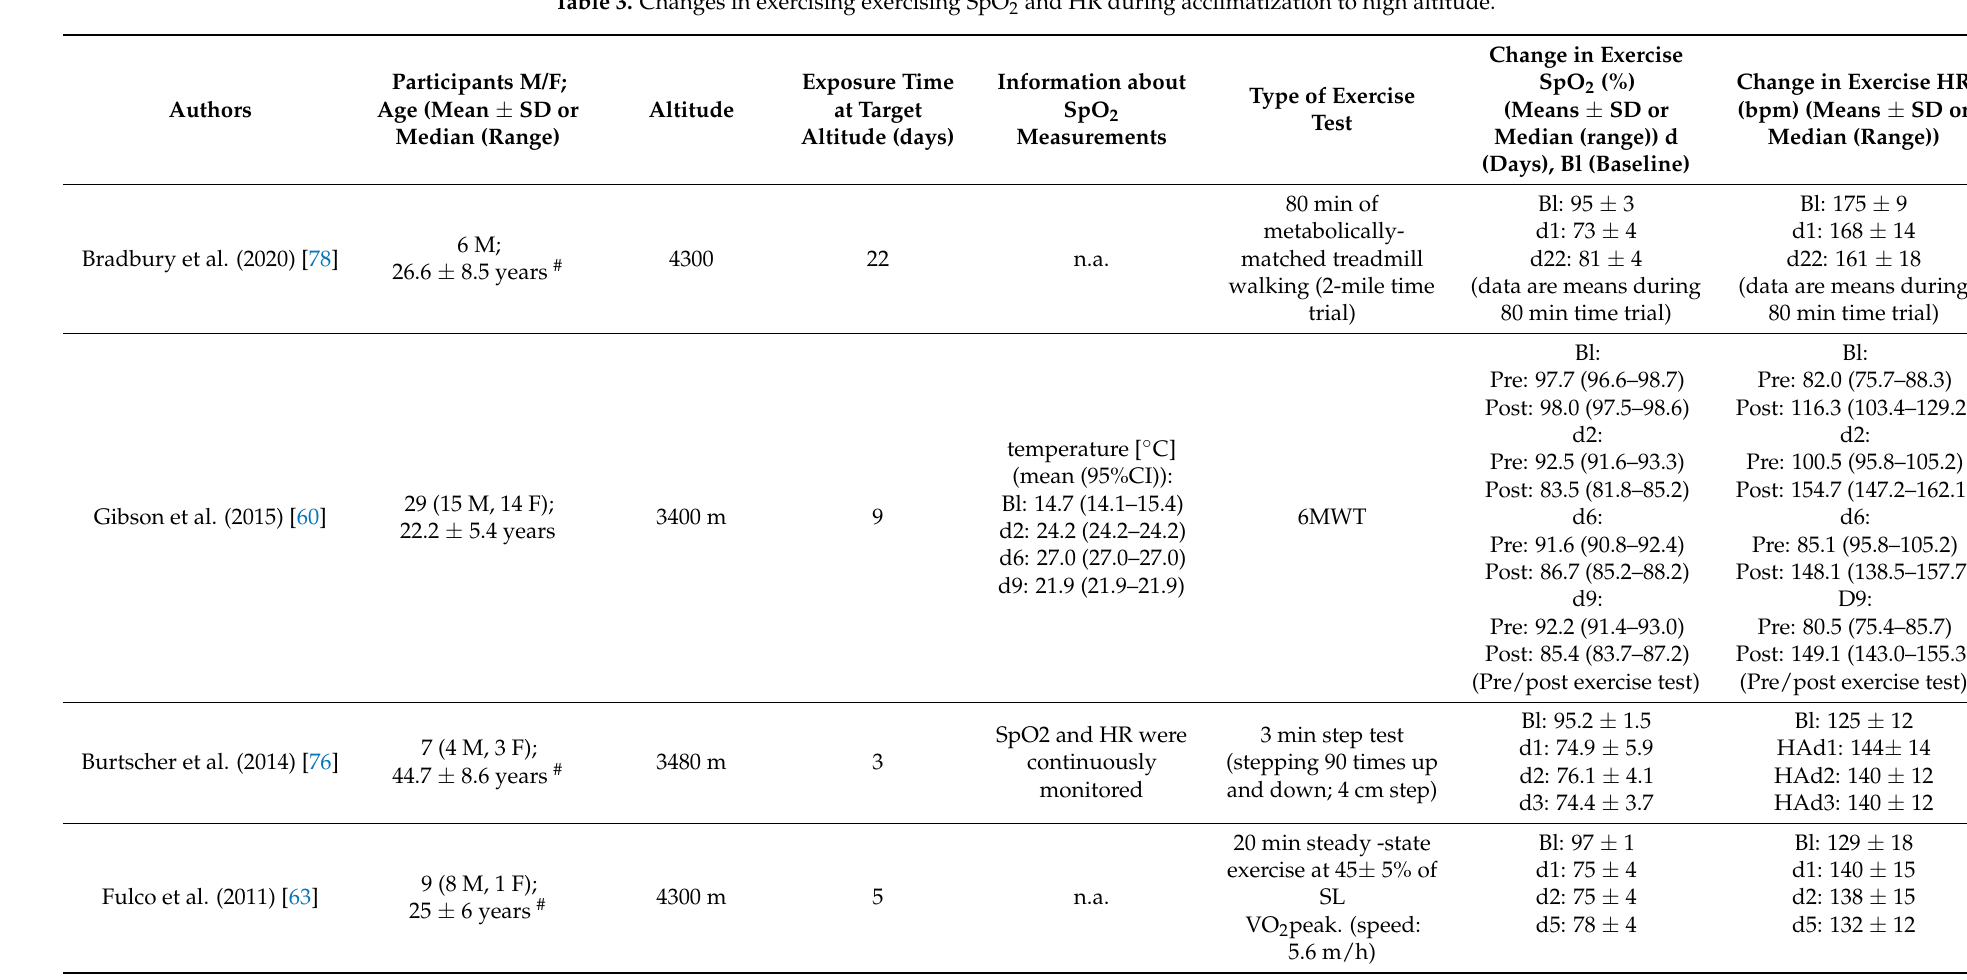
Table 3. Changes in exercising exercising SpO 2 and HR during acclimatization to high